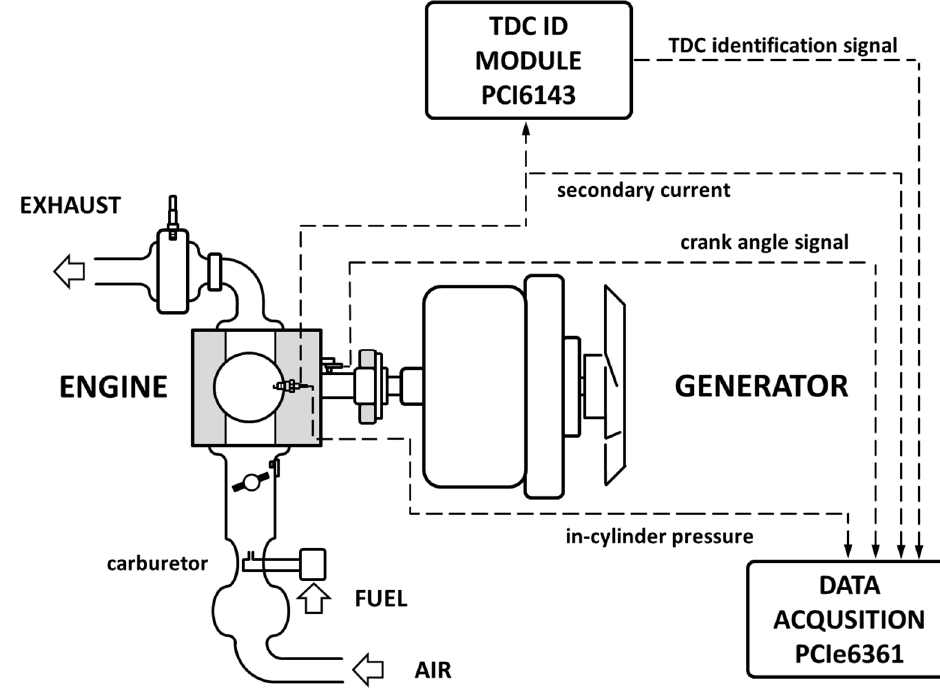
Figure 1. Schematic illustration of the experimental setup and acquired/control signals. Secondary current measurements featured an accuracy of ±1% and were performed on a 50 Ohm resistance. The converted voltage signal was acquired using a device that featured an accuracy better than 2 μ V at the ±10 V full scale. The data acquisition fre- quency was 50 kHz, equivalent to 0.48 and 0.62 deg crank angle resolution at the mini- mum and maximum engine speed of 4000 and 5200 rpm, respectively. In-cylinder pres- sure data was recorded with the same device as for secondary current traces and featured an accuracy of ±1% (given by the piezo-electric transducer and amplifier chain); the res- olution was 0.5 deg. The charge amplifier was operated in cyclic reset mode and no pressure referencing was performed.